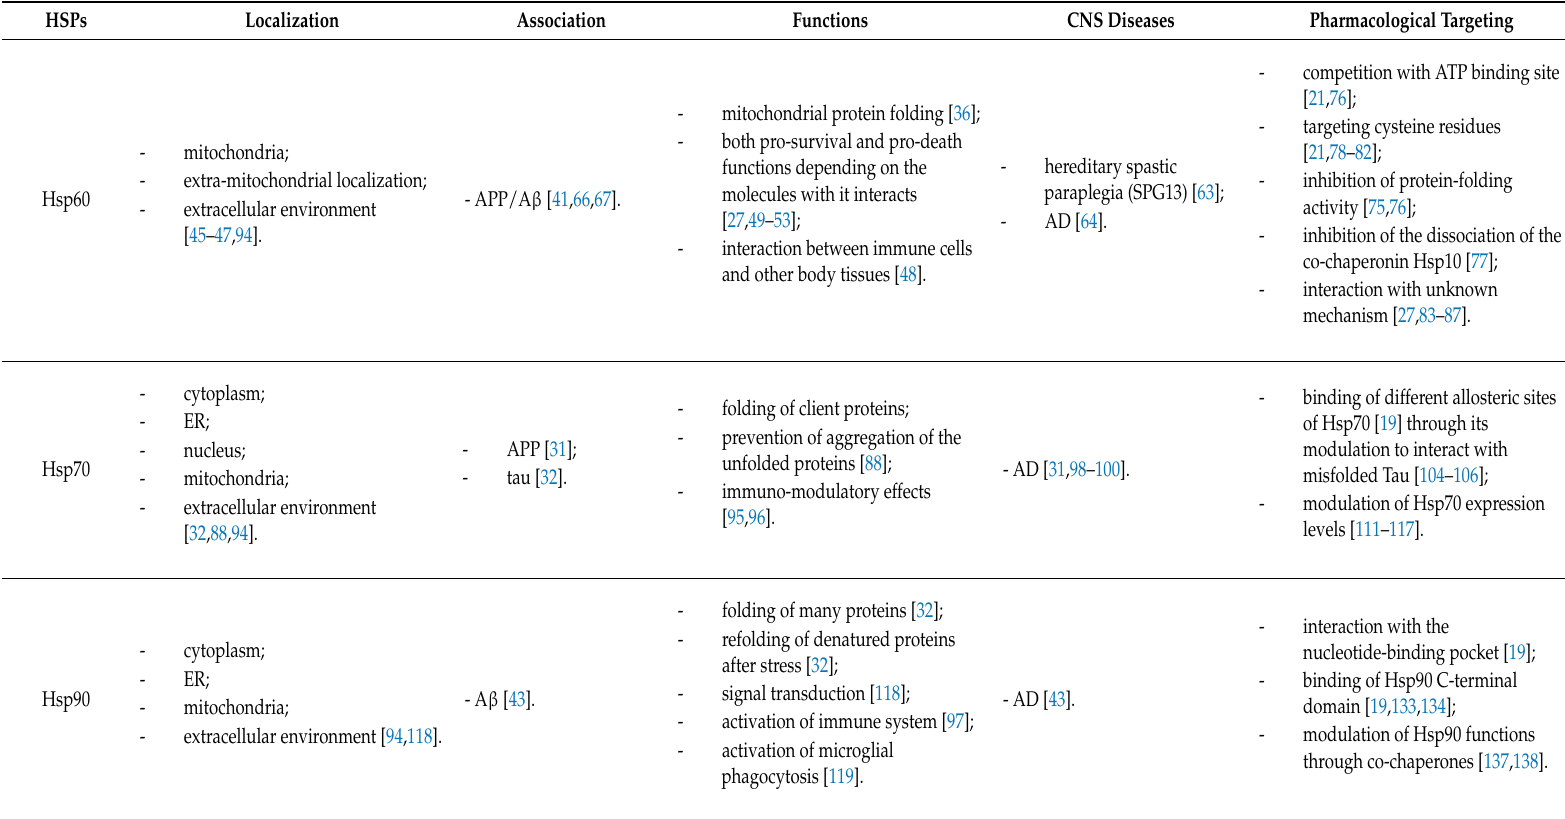
Table 2. HSPs localization, functions and involvement in AD and